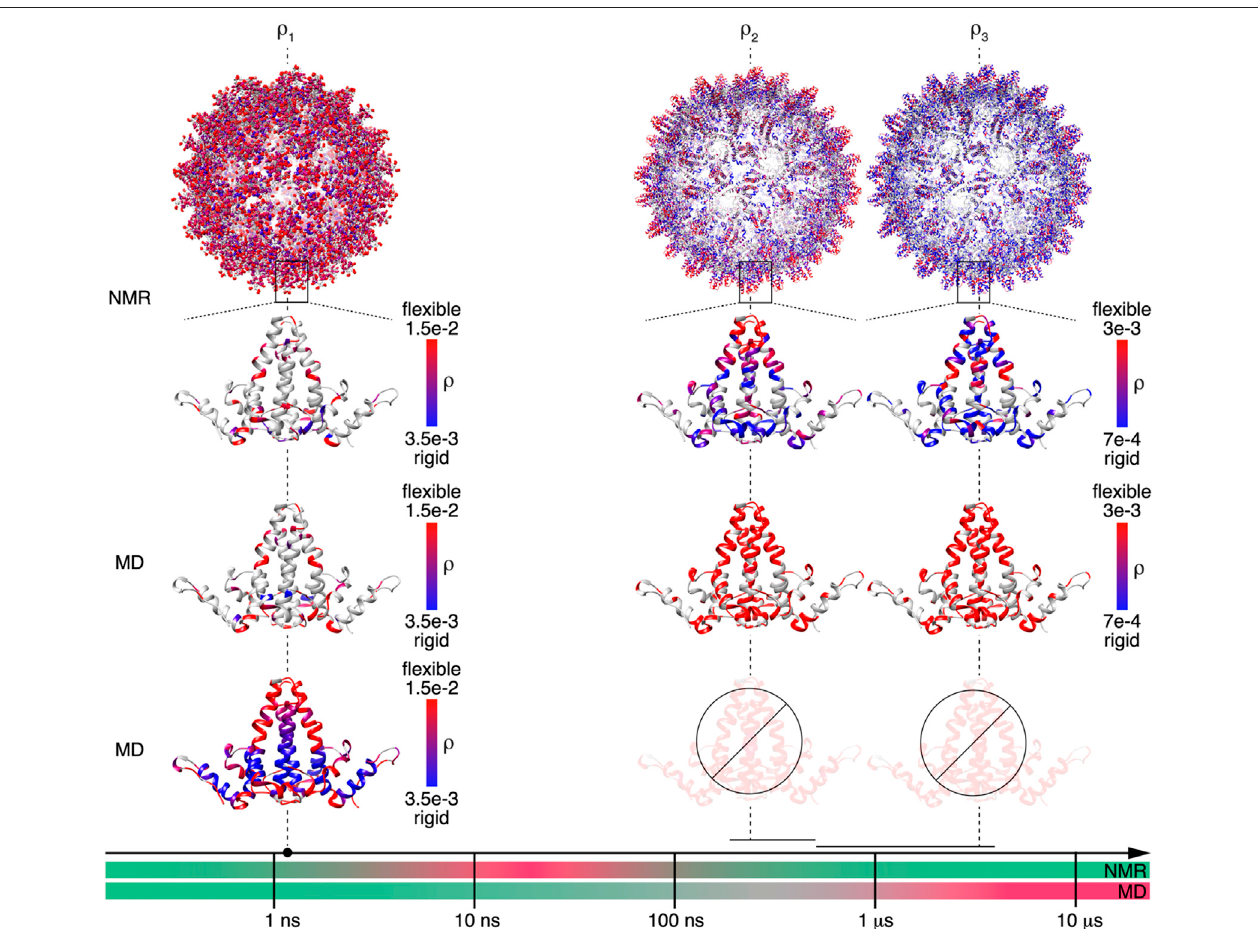
FIGURE 5 | NMR and MD are complementary methods for characterizing Cp149 capsid dynamics up to the microsecond timescale. Comparison of the MD and NMR amplitude of motions ρ ( θ , S ) 1 , ρ ( θ , S ) 2 and ρ ( θ , S ) 3 shown in a red to blue gradient on the Cp149 dimer structure (PDB 1QGT). The NMR data plotted on the full Cp149 capsid is shown on top (an intermediate scale representation is shown in Supplementary Figure S23 ). Residues not characterized by NMR are shown in grey. For easier comparison the fi rst panel containing MD results (Hadden et al. 2018) only shows the color-coding for those residues that are also observed by NMR, while the second MD panel shows the predictions that can be made with MD for the dynamics of the full dimer structure. The timescale arrow at the bottom is color-coded according to the timescales accessible (green) and not accessible (red) by state-of the art MD and NMR methods. The grey zone of MD corresponds to a timescale where the amplitudes of motion start showing increasing error bars as predicted by the MD error analysis presented in the Supplementary Information section S1 . The barred dimer representations in the bottom right indicate that in these timescales it is not possible to obtain reliable data extrapolations by MD.